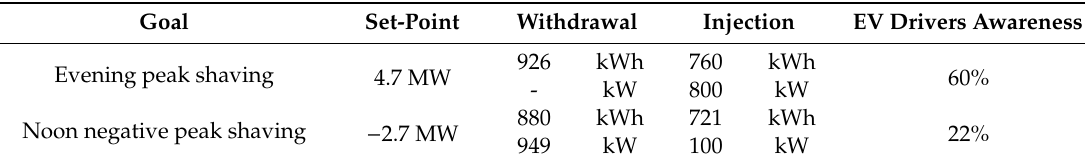
Table 5. Power and energy required for peak shaving services.